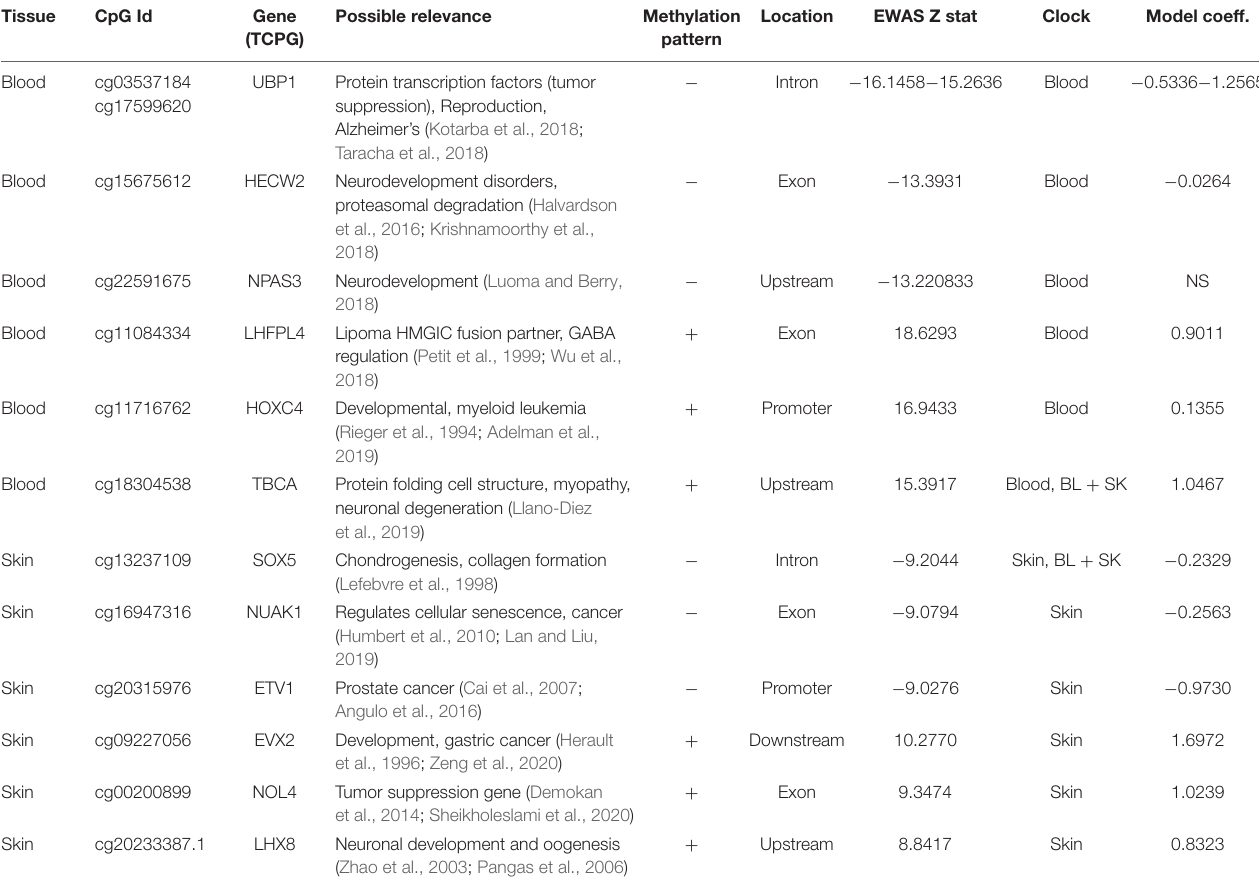
TABLE 2 | Epigenome-wide associated studies (EWAS) identification of top three hypo [ − ] and hyper [ + ] methylated age associated CpGs, its proximate gene, the epigenetic clock which included CpG site its coefficients. Tissue CpG Id Gene Possible relevance Methylation Location EWAS Z stat Clock Model (TCPG) pattern